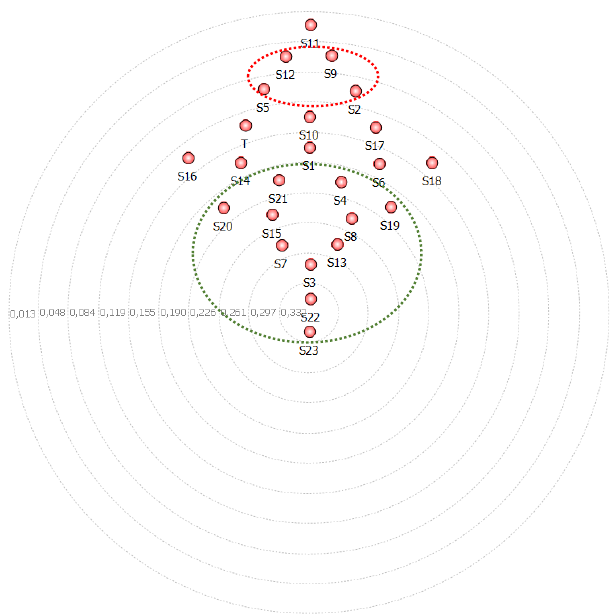
Figure 4. Eigenvector centrality map of the e-portfolio network